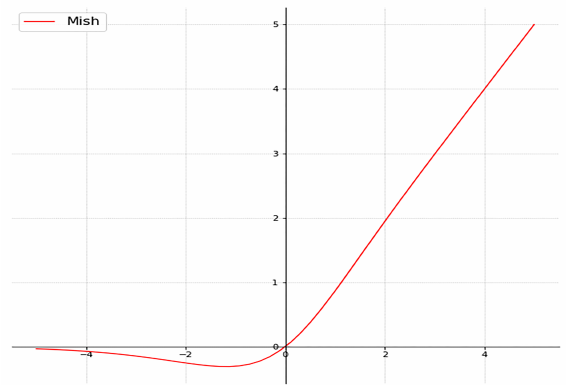
Figure 7. Mish activation function.